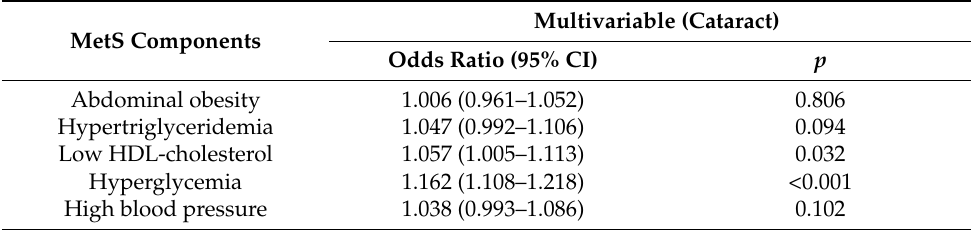
Table 4. Association of MetS components and cataract using multivariable logistic regression analysis. MetS